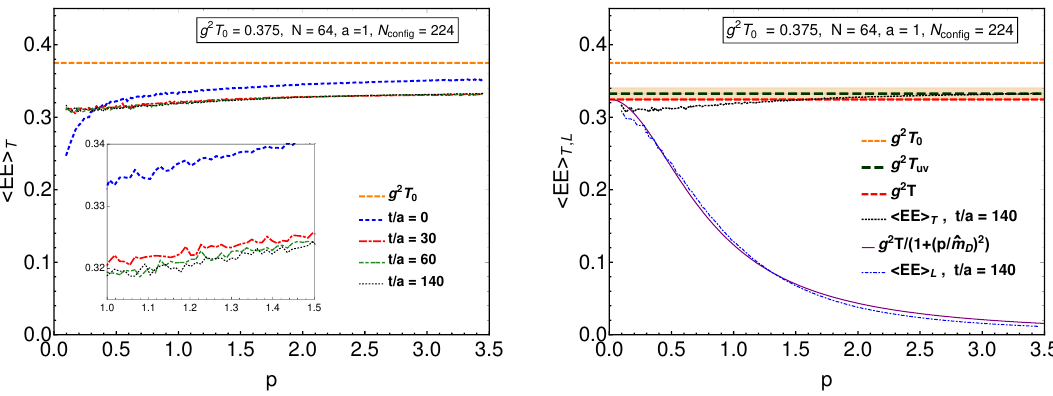
Figure 1 . (Left:) Example of thermalization for g 2 T 0 = 3 / 8 and a = 1 . The transverse chromo- electric field correlation is shown at different times of the simulated gauge dynamics. The inset shows a zoomed region of the plot. The dashed orange line corresponds to the field initialization (2.10) with g 2 T 0 before the Gauss law is restored. (Right:) Extracting T and ˆ m D by fitting (2.12) to transverse and longitudinal chromo-electric field correlations. The fit functions are given by the black dashed and continuous purple lines. The red dashed line corresponds to the value g 2 T UV at the hardest momentum, the shaded error band shows the systematic error in the estimation of the temperature [ T − ∆ T, T + ∆ T ] with ∆ T = T UV − T